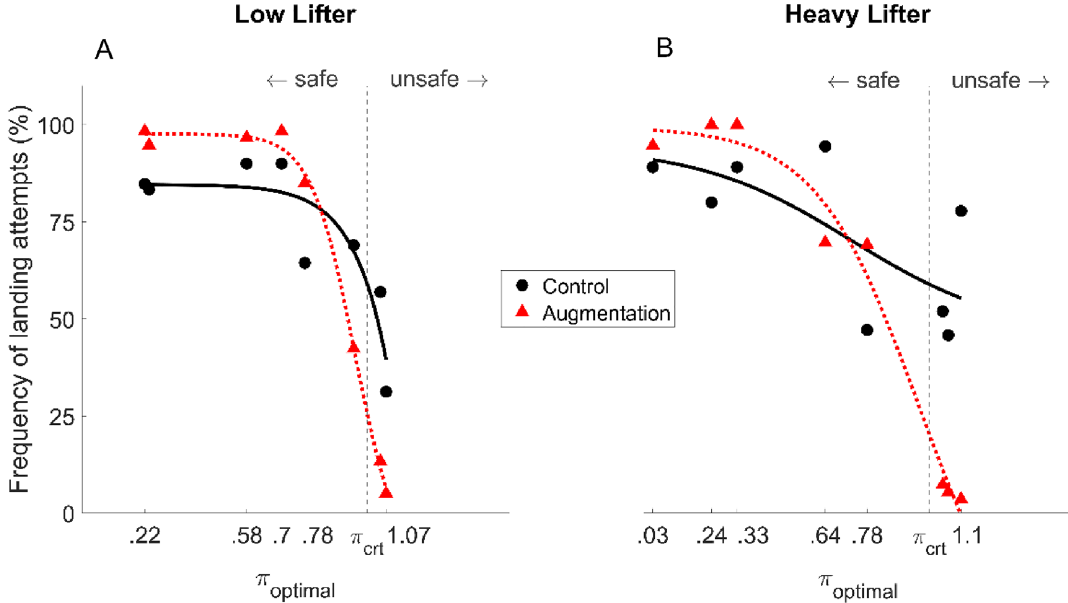
Figure 5. Inter-individual mean frequency of attempted deck-landing maneuvers expressed as a function of π optimal for Control ( A , B ) and Augmentation conditions ( C , D ) and for LL ( A – C ) and HL ( B – D ) groups. The red curve depicts the mean sigmoid function fitted on inter-individual mean frequency.